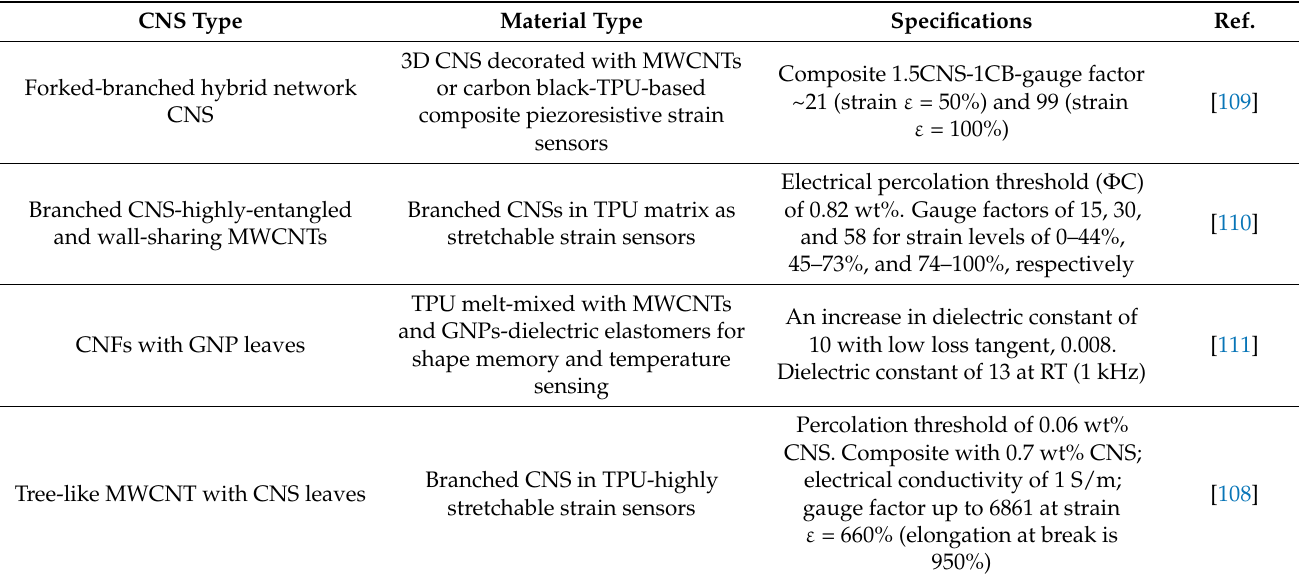
Figure 7. ( a ) Three-dimensional schematic illustration of the fabrication process for the bSi-CNT structure. ( b – d ) SEM images showing side views (top panels) and top views (bottom panels) of the bSi-CNT sample corresponding to ( a ). Reproduced from [105], under a Creative Commons license http://creativecommons.org/licenses/by/4.0/ (accessed on 13 October 2021). Table 4. Examples of branched CNSs used in EMW technology.